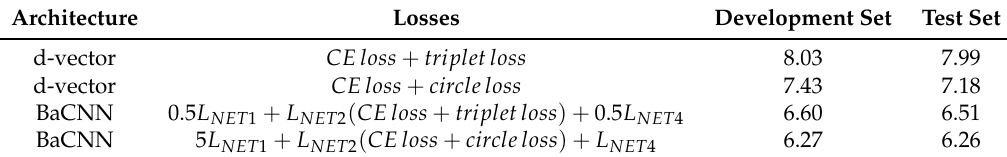
Table 2. The EERs (%) on the development and test sets with different